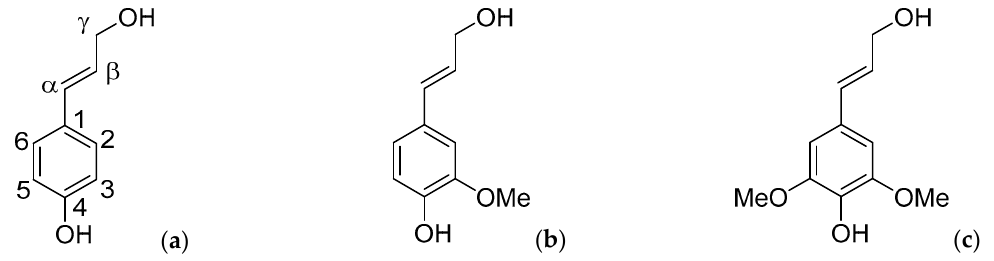
Figure 1. The lignin monomeric building blocks ( a ) p -coumaryl alcohol (H); ( b ) coniferyl alcohol (G); and ( c ) sinapyl alcohol (S).